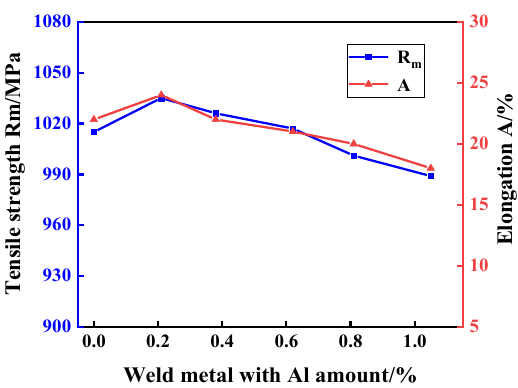
Figure 8. Effect of Al content on tensile properties of weld metal.